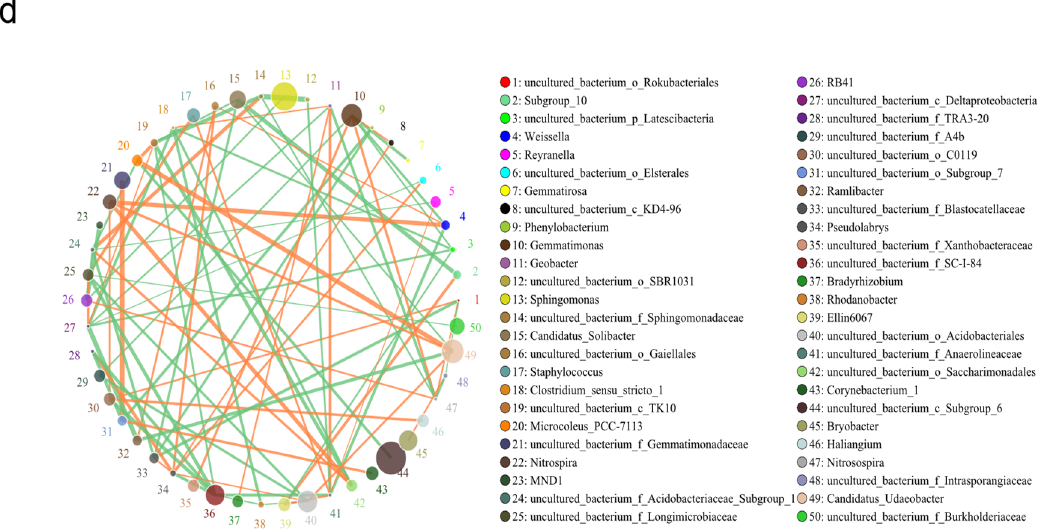
Figure 4. Correlation network analysis of soil bacteria phyla in a dry direct-seeded rice paddy soil under different fertilization treatments. NPK ( a ) conventional fertilization, OF1 + NPK ( b ) seaweed bio-organic fertilizer and NPK, OF2 + NPK ( c ) Jishiwang bio-organic fertilizer and NPK, and OF3 + NPK, ( d ) attapulgite organic fertilizer and NPK. Each node represents each dominant phylum and is identified by a different color. The edge connecting two nodes indicates the correlation between two phyla, with the orange line indicating a positive correlation and the green line indicating a negative correlation. The node size indicates the degree of association between the g phyla and other phyla of the community. The node size increases with the degree. Different colors represent different degrees of nodes.